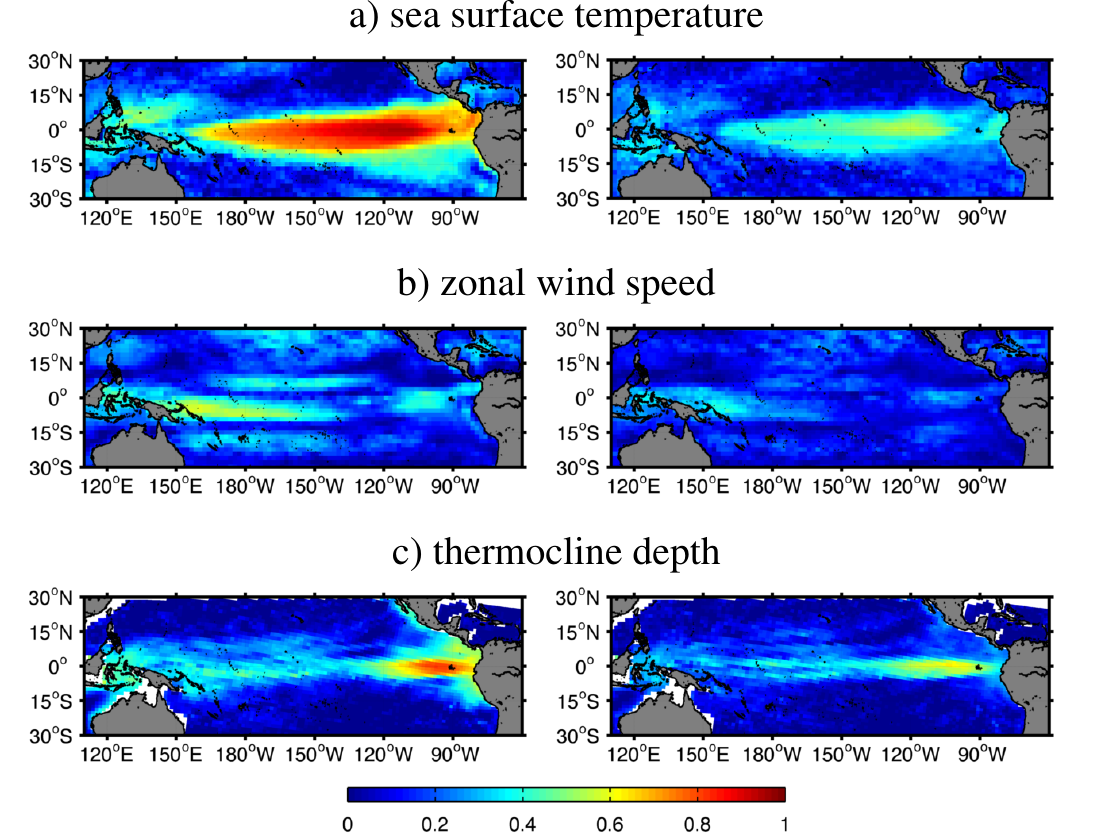
Fig. 4. Composite over 20 CT El Ni˜no events of the predictive power, PP(NINO3), gained by assimilating observations in JFM(0) for a given location (left panels); and the composite predictive power remaining in June (right panels). Assimilated quantities are a) the SST, b) the zonal wind speed or c) the thermocline depth.